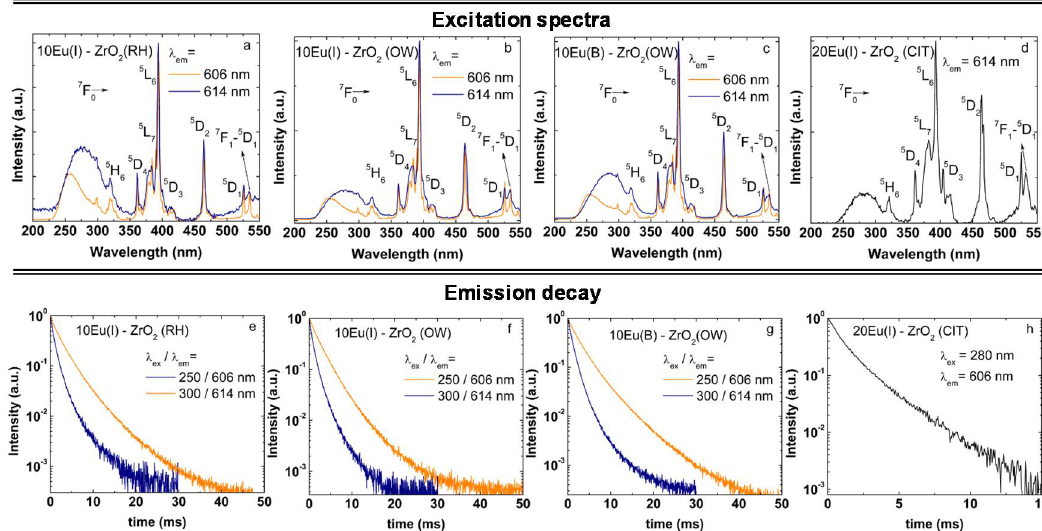
Figure 4. Comparison between excitation spectra and emission decays of 10Eu(I)–ZrO 2 (OW, RH) and 20Eu(I)–ZrO 2 (CIT). For comparison only, the excitation spectra and emission decays of 10Eu(B)–ZrO 2 (OW) are also included. To separate the tetragonal and monoclinic contributions, the monitored emission wavelengths were set at 606 and 614 nm, while the excitation wavelengths were set at 250 and 300 nm. All samples were annealed at 1000 °C. The measurements were performed at room temperature. Table 2. Average lifetimes of 10Eu(I)–ZrO 2 (OW, RH) and 20Eu(I)–ZrO 2 (CIT) annealed at 1000 °C estimated from the emission decays displayed in Figure 4e–h.